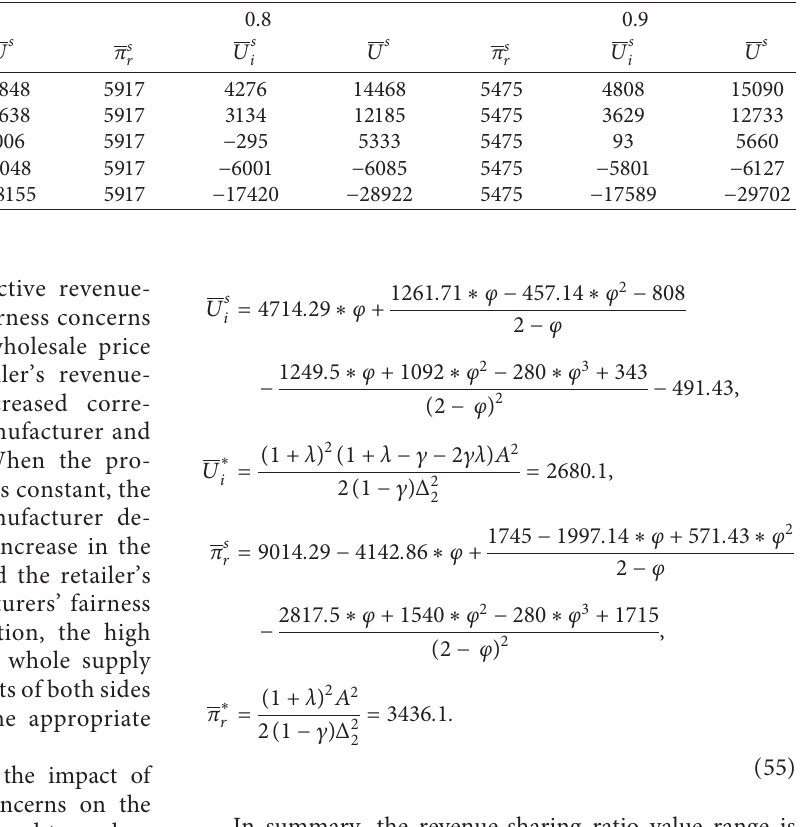
Table 4: Impact of changes in other